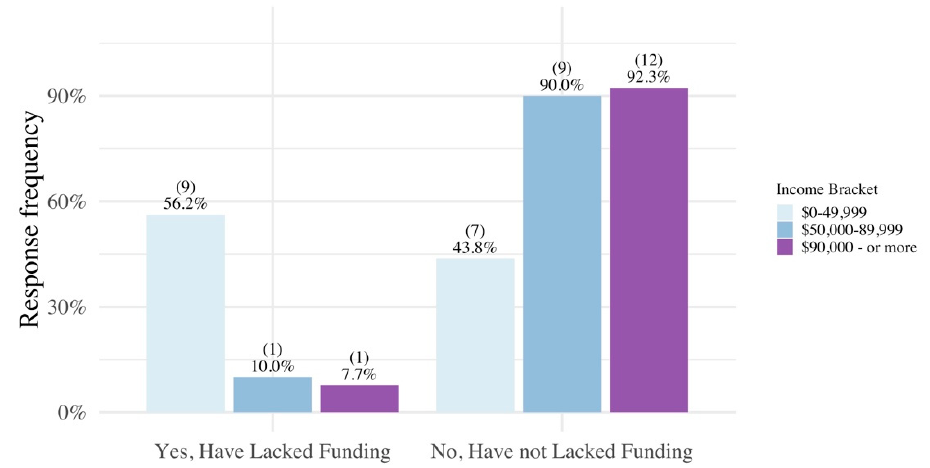
Figure A6. Knowledge of participants regarding potential sources of exposure to soil contaminants based on income (a) and the existence of children (b). Total question respondents: 41.